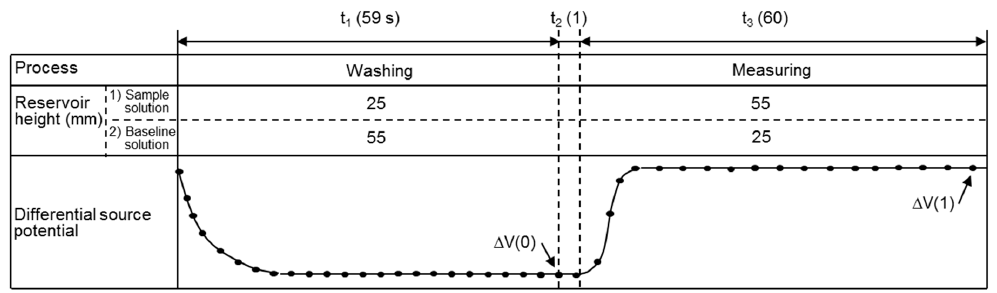
Figure 3. Time course of one sample-measurement cycle: t 1 , washing the pH-FET m sensor and channel inside; t 2 , switching the reservoir heights; t 3 , measurement.